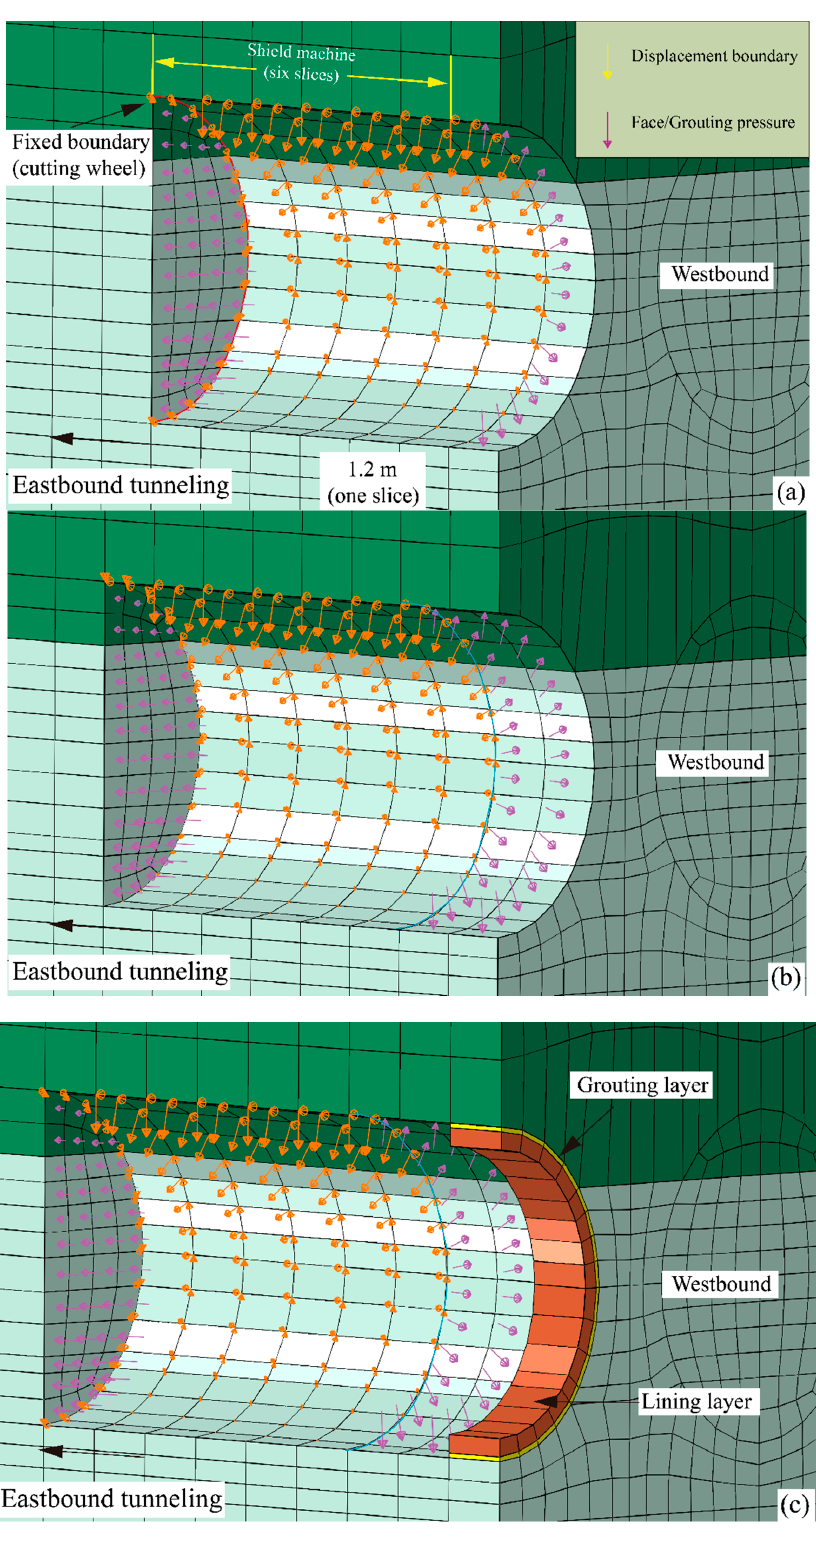
Figure 6. FEA modelling procedure: ( a ) step 1; ( b ) non-uniform contraction applied at the TBM boundary; and ( c ) activation of lining and grouting layer (redrawn after [34]).